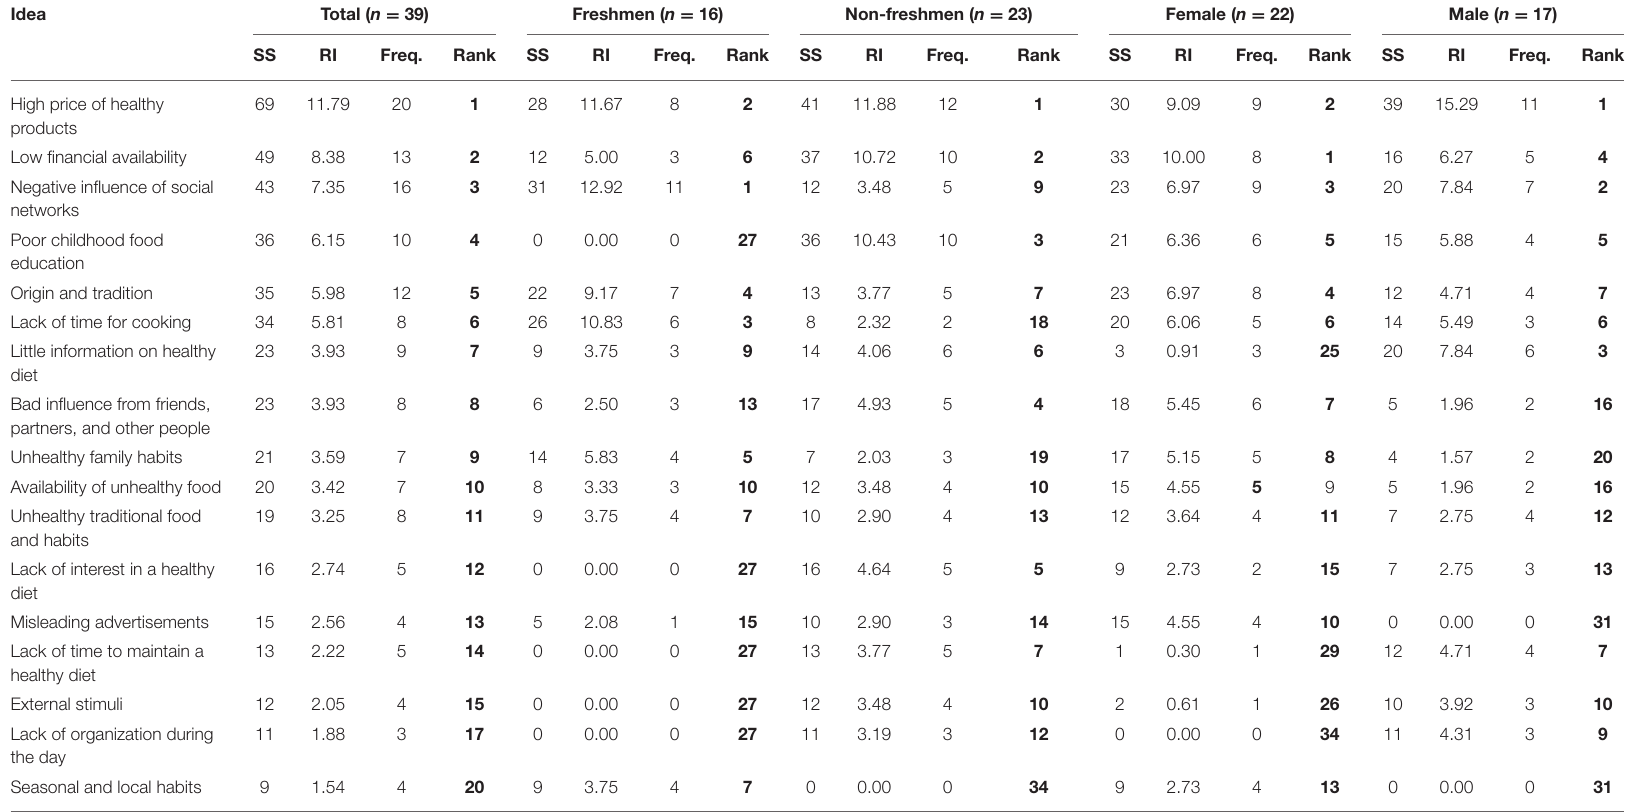
TABLE 4 | Aggregated results across the 7 groups on objective barriers to maintaining a healthy